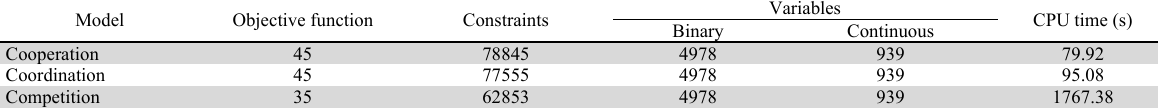
Model sizes and computational statistics for each policy at Example 2